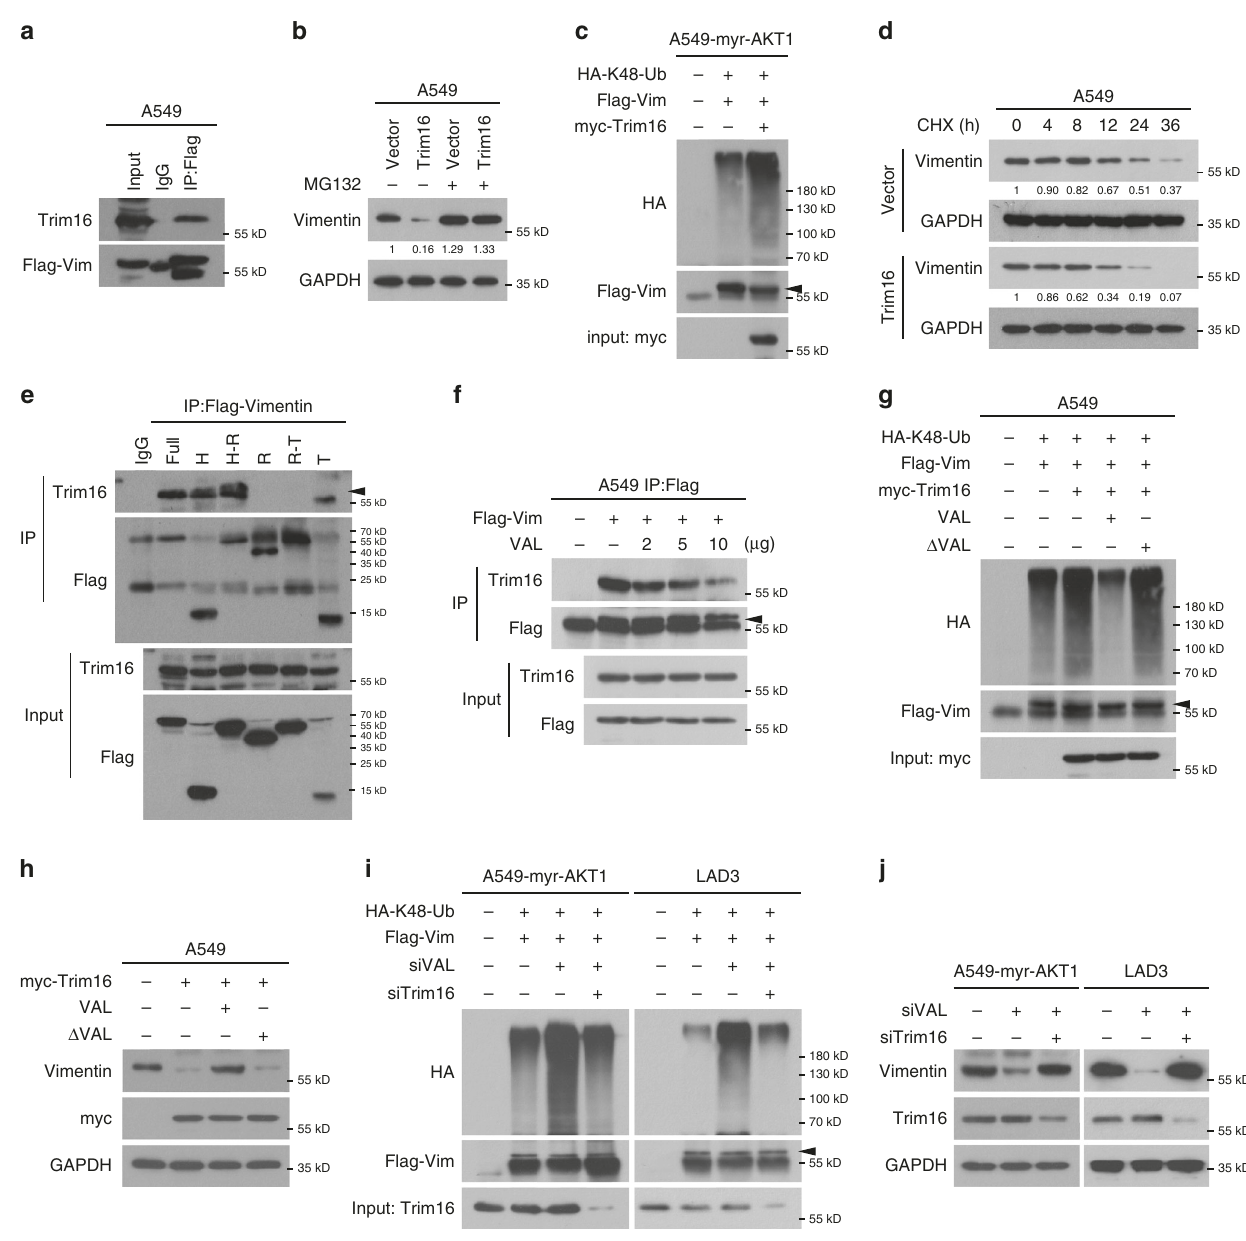
Fig. 6 VAL abrogates Trim16-induced degradation of Vimentin. a Co-IP assay following immunoprecipitation of Flag-tagged Vimentin shows the interaction of Vimentin with Trim16. b WB analysis of Vimentin expression in vector-control or Trim16-overexpressing A549 cells treated with or without MG132. c The effect of overexpressing Trim16 on the levels of K48-linked polyubiquitination of Vimentin was evaluated by immunoprecipitation of FLAG- tagged Vimentin in myr-AKT1-overexpressing A549 cells. d The half-life of Vimentin proteins were evaluated in vector-control or Trim16-overexpressing A549 cells treated with CHX and collected at the indicated time points. e Interaction between Trim16 and different truncated mutants of Flag-tagged Vimentin was evaluated by co-IP assays in 293FT cells. f The effect of overexpressing VAL in a dose-dependent manner on the interaction between Trim16 and Flag-tagged Vimentin as evaluated by immunoprecipitation of Flag. g The effect of overexpressing Trim16 on the levels of K48-linked polyubiquitination of Vimentin in the presence of overexpressed VAL or of Δ VAL was evaluated by immunoprecipitation of FLAG-tagged Vimentin in A549 cells. h WB analysis of Vimentin levels in A549 cells with the indicated treatments. i The effect of silencing VAL or together with silencing Trim16 on the levels of K48-linked polyubiquitination of Vimentin in A549-myr-AKT1 or LAD3 cells. j WB analysis of Vimentin levels in A549-myr-AKT1 or LAD3 cells silenced with VAL or together with Trim16 knockdown. Representative images derived from one of three independent experiments are presented. Relative protein levels were quanti fi ed by scanning densitometry and calculated as Band Intensity of Protein of Interest/Band Intensity of GAPDH ( b , d ). Source data are provided as a Source Data fi